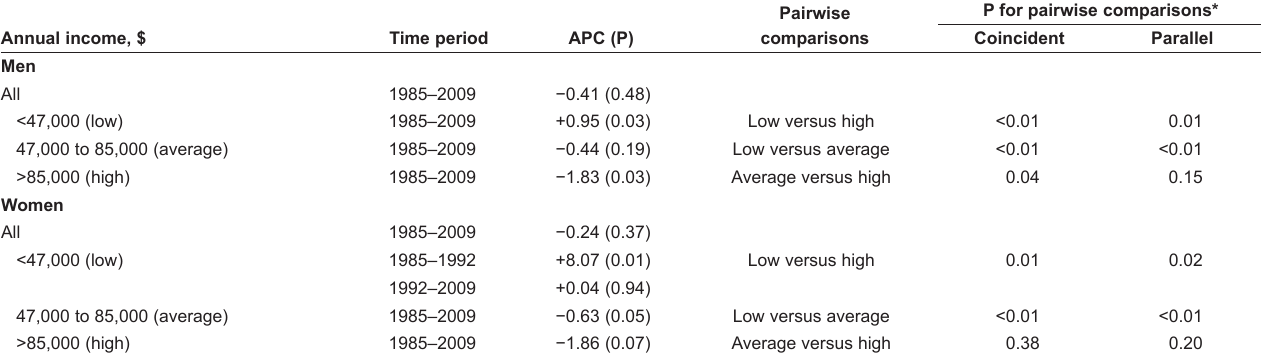
TABle 2 Time trends in overall colorectal cancer mortality rate according to sex and